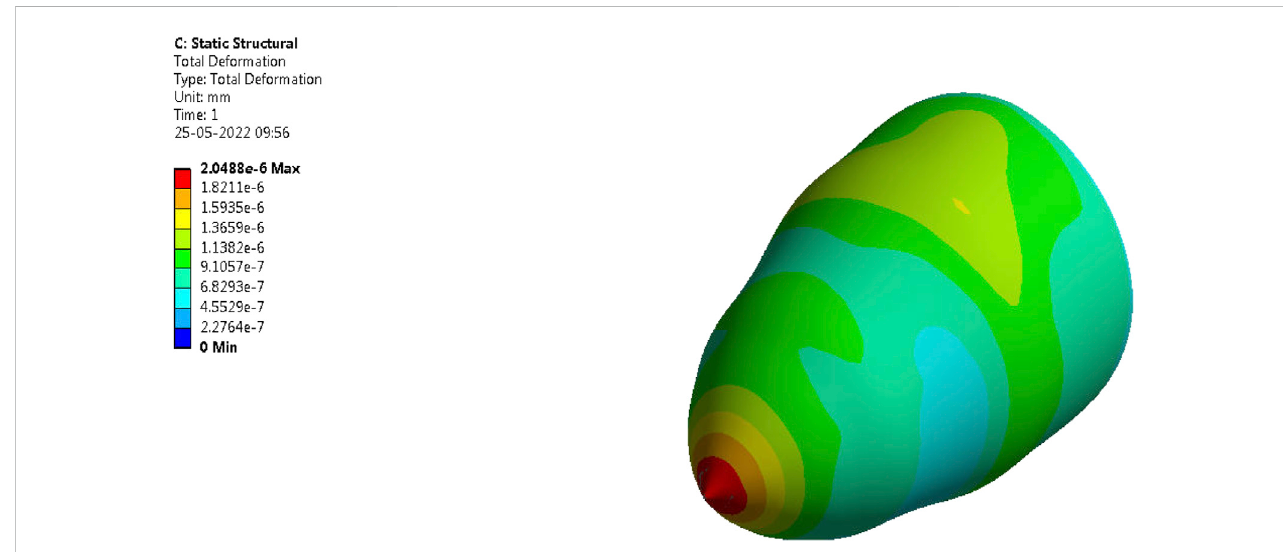
FIGURE 13 Total deformation on half fuselage of RUAV with Epoxy-Carbon-Woven-Wet.